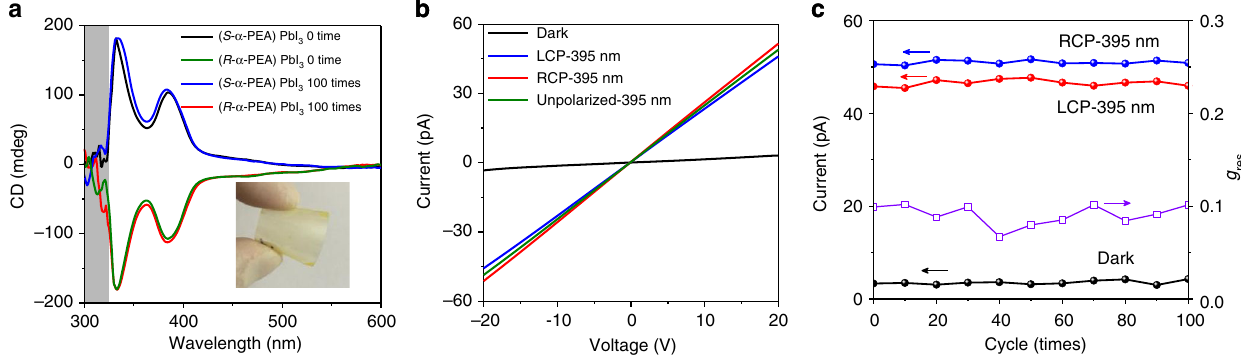
Fig. 4 Device performance of ( α -PEA)PbI 3 fi lms on fl exible PET substrate. a The CD spectra of ( R - and S - α -PEA)PbI 3 fi lms on PET substrates without bending and with 100-times bending. Inset is the digital photograph of the fi lm on PET substrate. b The current-voltage curves of ( R - α -PEA)PbI 3 device under dark, LCP-395, RCP-395, and unpolarized-395 nm light illumination. The light intensity was 5 μ W cm − 2 . c The current under dark, LCP-395 and